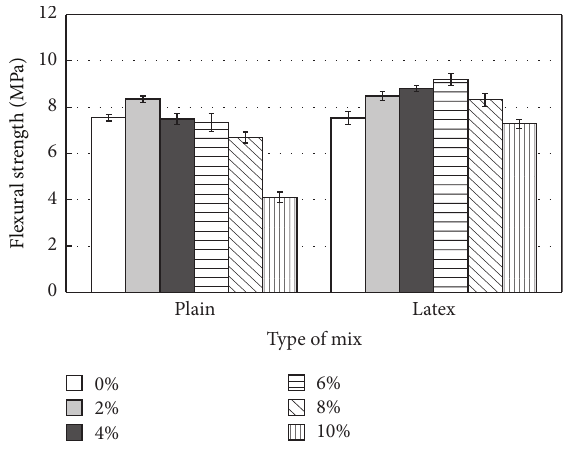
Figure 3: Flexural strength of PCC and LCC with nanosilica contents.